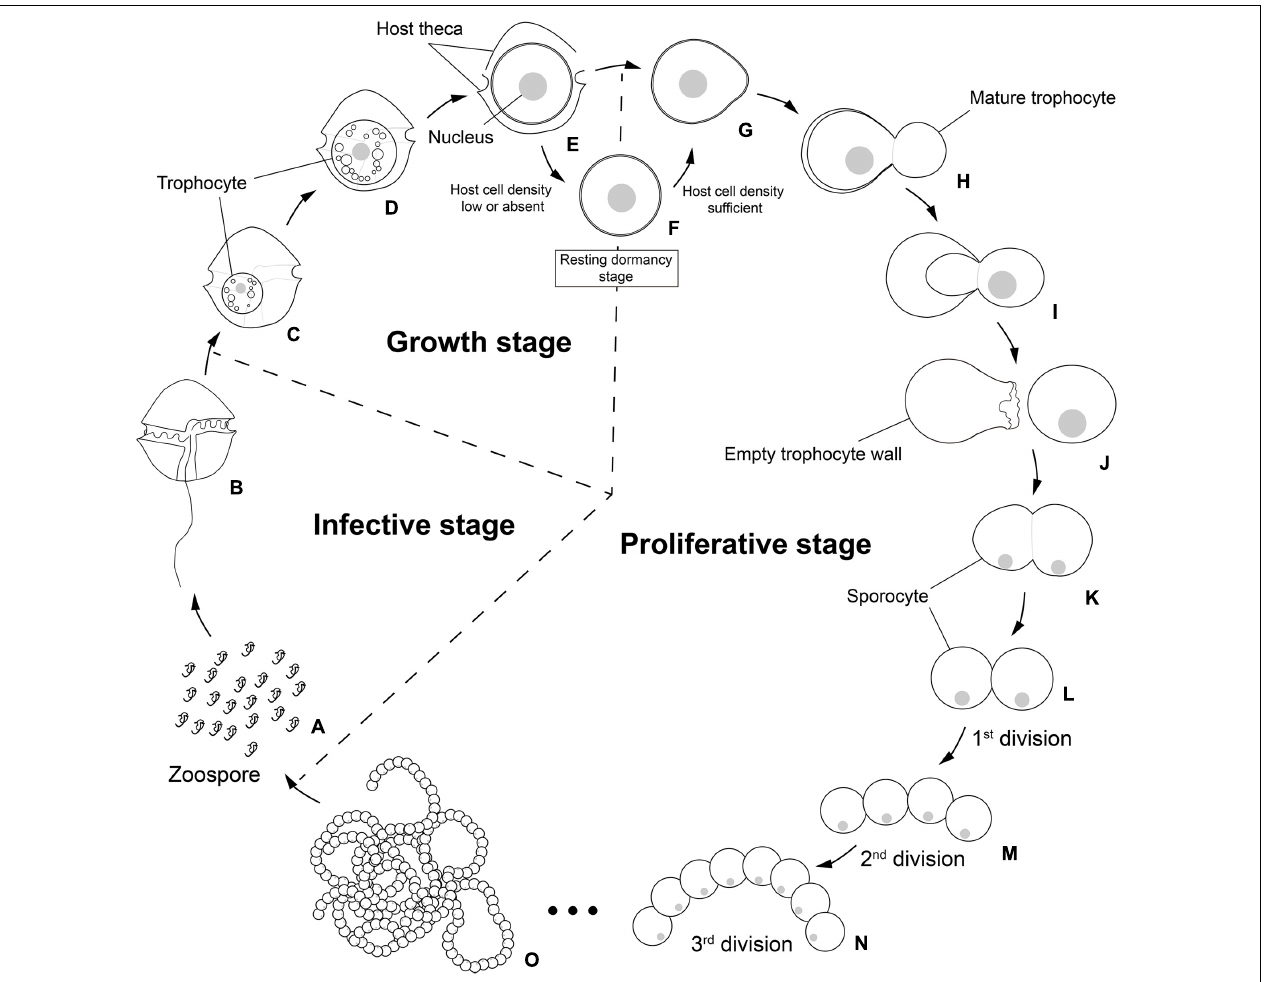
FIGURE 8 | Schematic life cycle of the parasitoid Pararosarium dinoexitiosum infecting the dinoflagellate host Alexandrium pacificum . The life cycle of the parasitoid comprises three stages, an infective stage (A,B) , a growth stage (C–E) , a resting dormancy stage (F) , and a proliferative stage (G–O) . (A) Infective zoospores seek out a suitable host cell. (B) Healthy host A. pacificum . (C) Early trophocyte within host cytoplasm. (D) Middle to late trophocyte consuming the host cytoplasmic contents. (E) Late trophocyte with a large nucleus. (F) Resting dormancy stage of the late trophocyte when host cell density was low or absent. (G) The bulged trophocyte wall of late trophocyte. (H–J) Emergence of the mature trophocyte from the trophocyte wall. (K) The sporocyte undergoing palintomic sporogenesis. (L–O) Progressively sporogenesis stages in the development of beaded sporocytes resembling a